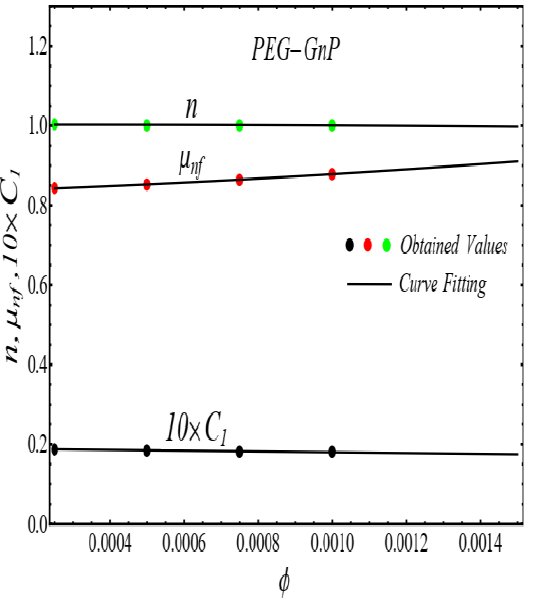
Figure 8. Curve fitting the Equation (4) for specified data in Table 1. Table 2. The values of coefficients of Equation (4).